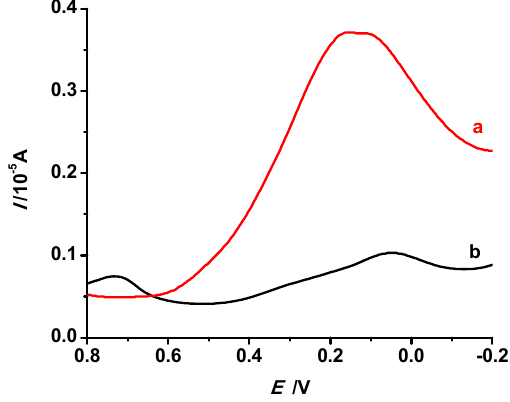
− 6 mol · L − 1 TBP with 0.3 mol · L − 1 KCl: ( a ) MIP/Au;